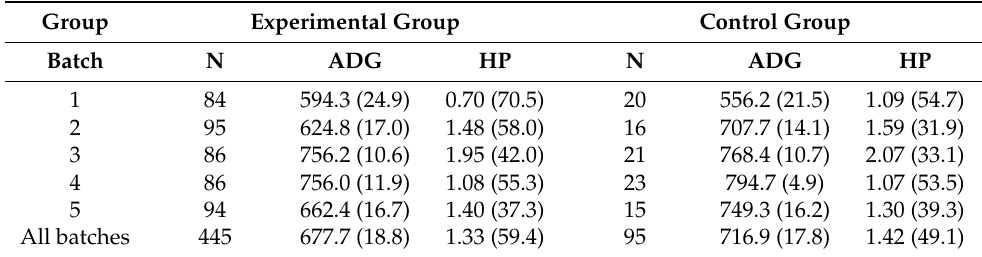
Table 1. Mean (coefficient of variation; %) for the average daily gain (ADG; g/day) between − 14 and 28 days post-vaccination (DPV) and the serum haptoglobin concentration (HP; mg/mL) at 4 DPV. Group Experimental Group Control Group